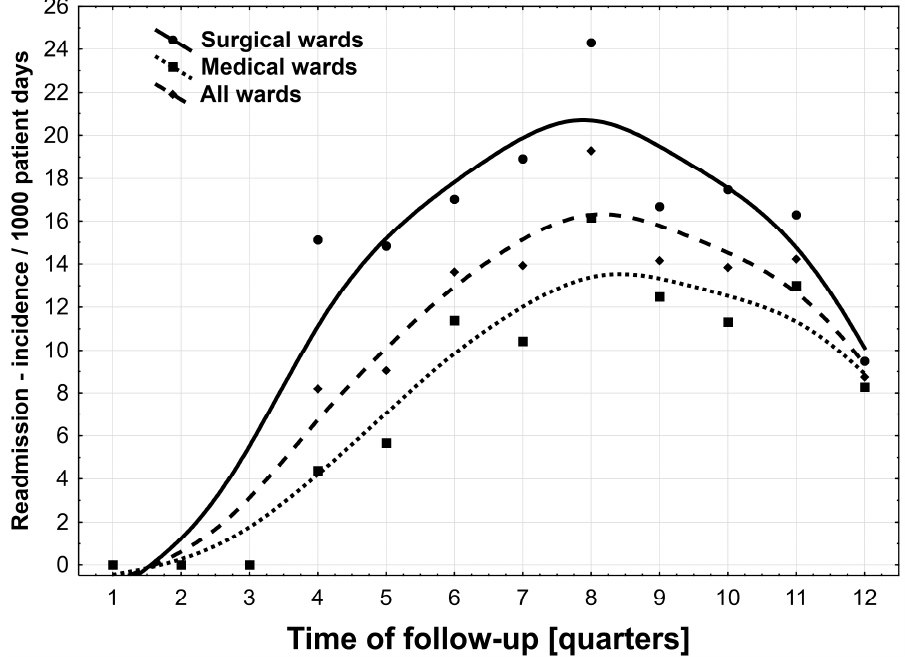
Figure 1. Readmission rate in the following quartiles in 2012–2014, in total as well as in surgical and non-surgical wards.